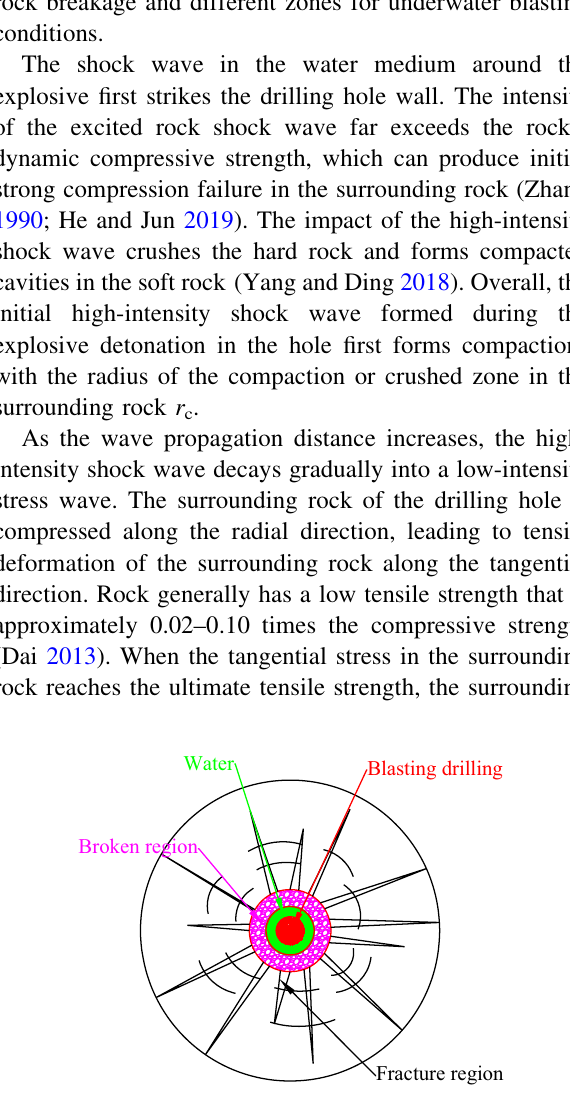
Fig. 1 Fracture development and partitioning during underwater blasting